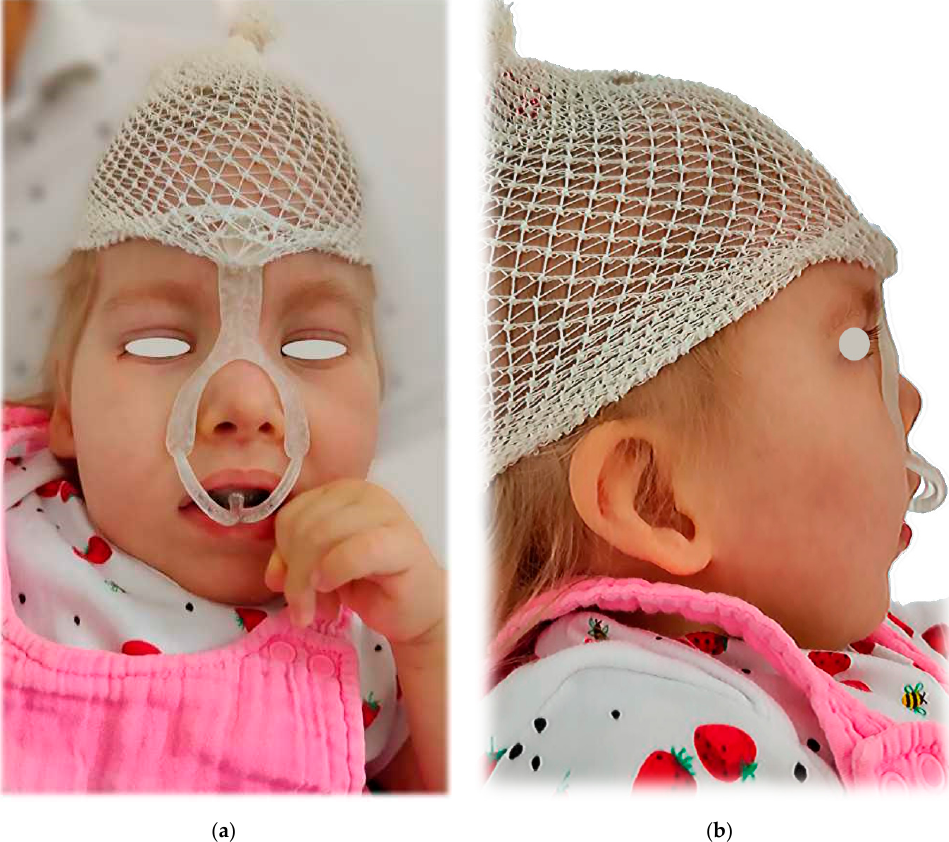
Figure 22. The clinical application on the patient: ( a ) frontal view; ( b ) lateral